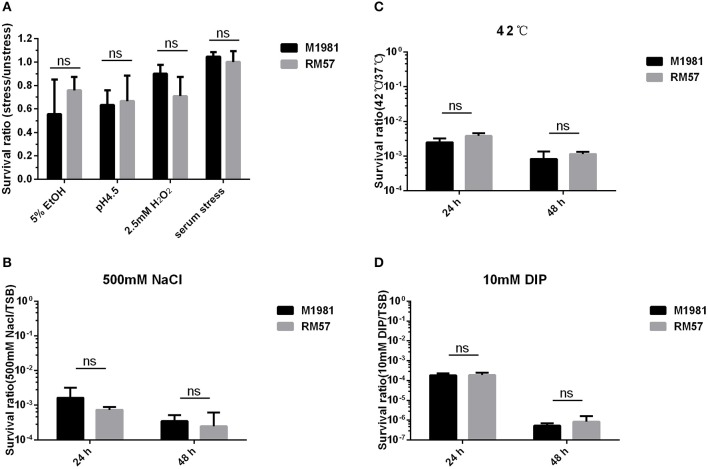
(A) The survival ratio of RM57 and M1981 cultured in TSB (5% EtOH, pH4.5, 2.5 mM H2O2, and non-immune serum) for 2 h. (B) The survival ratio of RM57 and M1981 cultured in TSB at 42°C (heat shock stress). (C) The survival ratio of RM57 and M1981 cultured in TSB with 500 mM NaCl (hypertonic environment). (D) The survival ratio of RM57 and M1981 cultured in TSB with 10 mM 2′2-dipyridyl (iron deficiency).